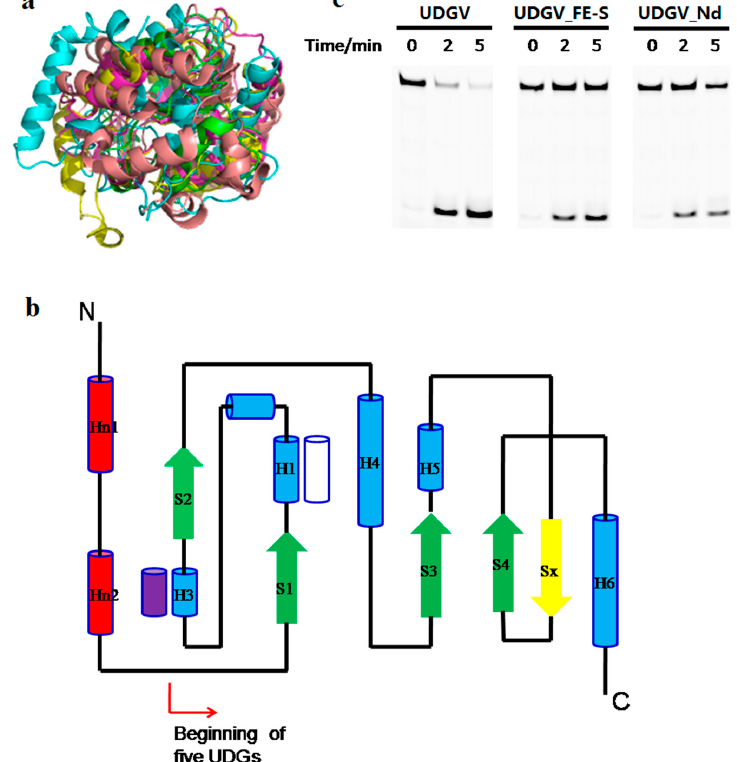
Figure 6. Structural and sequence multialignment of family I to V UDGs. ( a ) Superimposition of five members from UDG superfamily. Each UDG is shown in yellow (TthUDGV, PDB ID: 2d3y), green (EcMUG, PDB ID: 1mug), cyans (EcUNG, PDB ID: 1eug), wheat (GmeSMUG, PDB ID: 5h98), and purple (TthUDGIV, PDB ID: 1ui0), respectively; ( b ) topology structure of UDG superfamily. The topology of each member of UDG superfamily shows a conserved and unique feature. The secondary-structure elements of the UDG fold are colored as following: common α helices are shown as blue cylinders (the white one is missing in family 1, and the purple one is missing in family 5), and β -strands as green arrows (the yellow one is specific to MUG). The red cylinders are specific to the N-terminal domains of UDGs, excluding the MUG family. ( c ) Effect of N-terminal helices and [4Fe-4S] on dU removal by